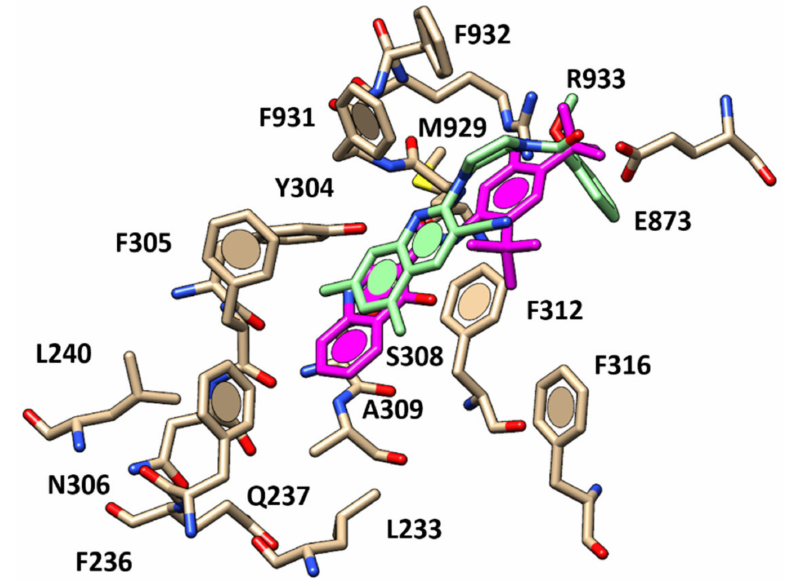
Figure 8. Docking positioning of compound 45 ( C atom; light green) within the X-ray crystallographic structure of the human CFTR in the presence of the docked VX-770 ( C atom;